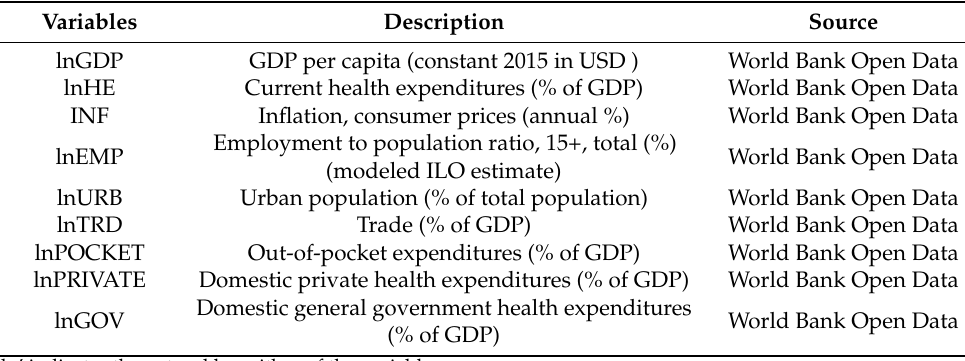
Table 1. Description of